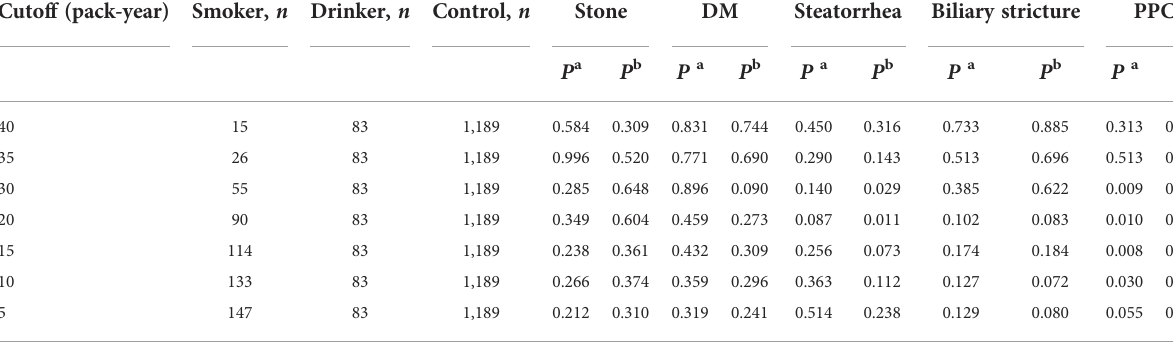
TABLE 1 Comparison between different cutoffs of smoking. Cutoff (pack-year) Smoker, n Drinker, n Control, n